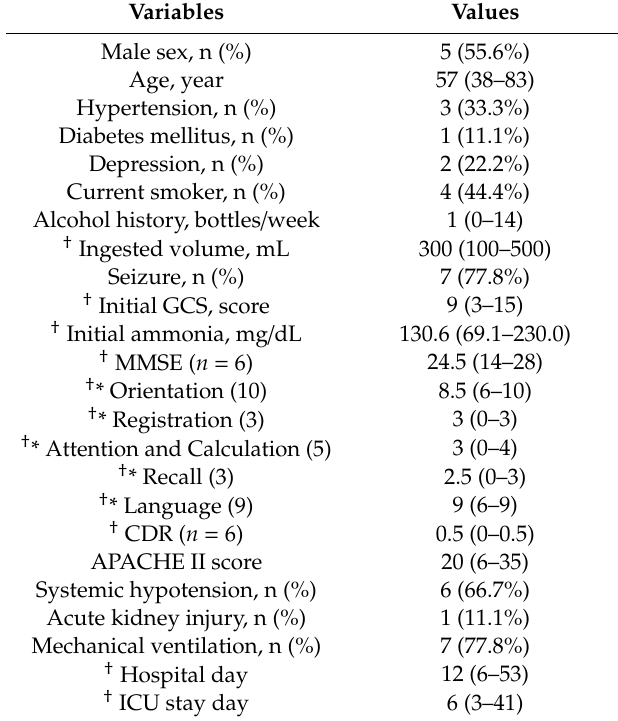
Table 1. Clinical characteristics of patients who su ff ered from memory impairment associated with glufosinate ammonium intoxication ( n =